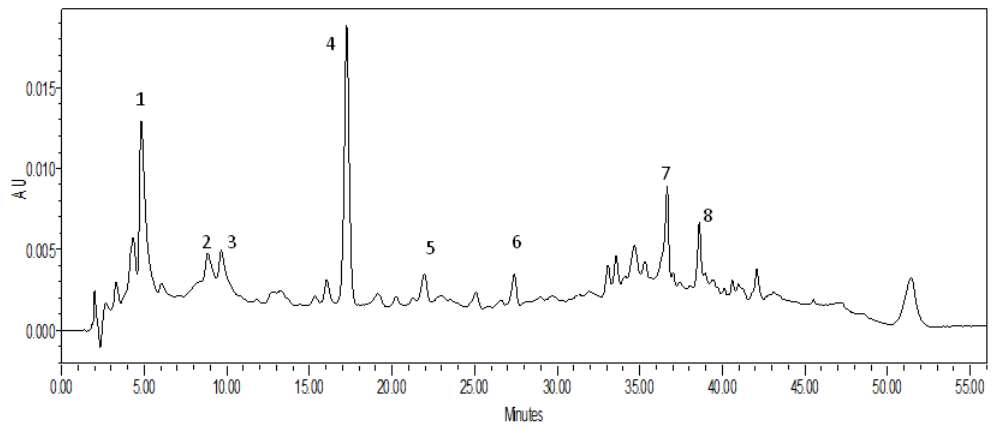
Figure 1. Chromatogram of the lipophilic fraction (F3) obtained from sweet pepper fruit. Numbered peaks are listed in Table 2.